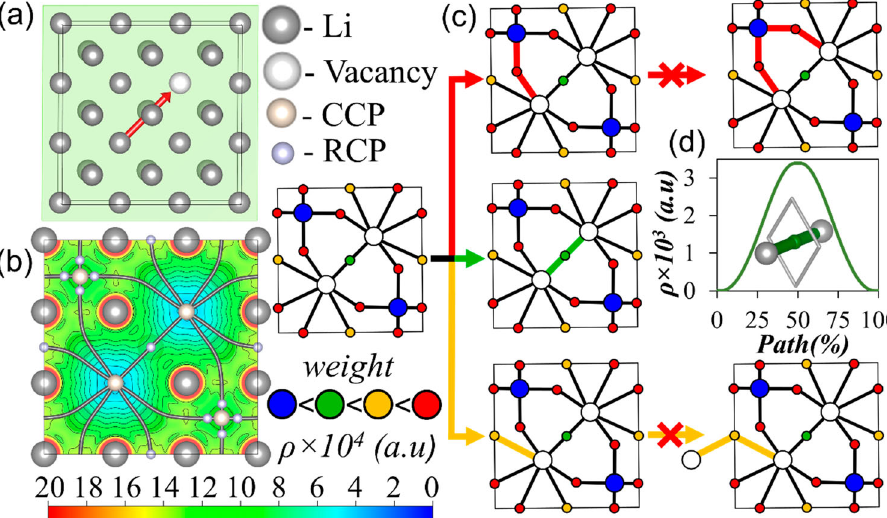
Fig. 6 Schematic illustration of the global MEDP search algorithm. 4.8 Å Li hop in the structure of bulk lithium metal ( a ). Topology of the electron density ( b ) and its representation as a graph ( c ). Graph nodes are colored with respect to weight, i.e., value of electron density. Red, green, and yellow arrows illustrate the steps of the algorithm that searches for the lowest barrier route (green) between the initial and fi nal positions (white circles) of the ion; notice how in ( c ) the red and yellow routes involve higher energies than the green path. Trajectory and electron density pro fi le of the global MEDP ( d